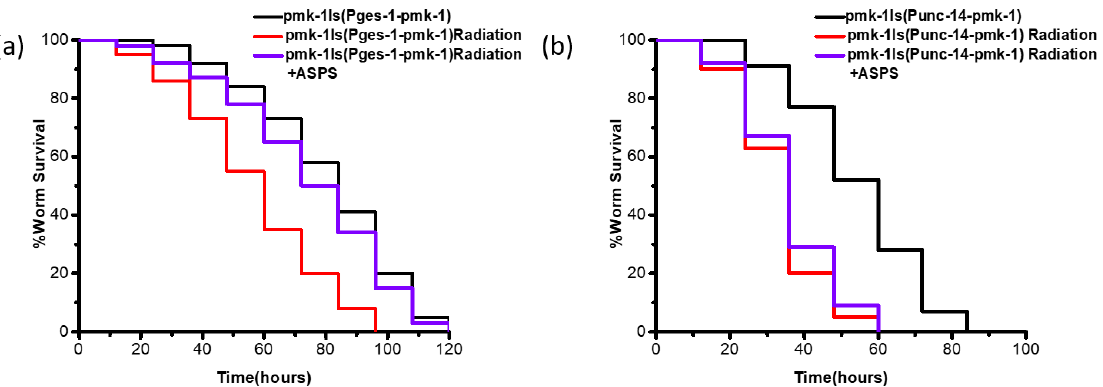
Figure 5. ASPS functioned in the intestine. ( a , b ) Tissue-specific rescue experiments. ASPS could significantly enhance the immune capacity of mutant expressing pmk-1 only in the intestine. n = 3. p < 0.01 (log-rank test).